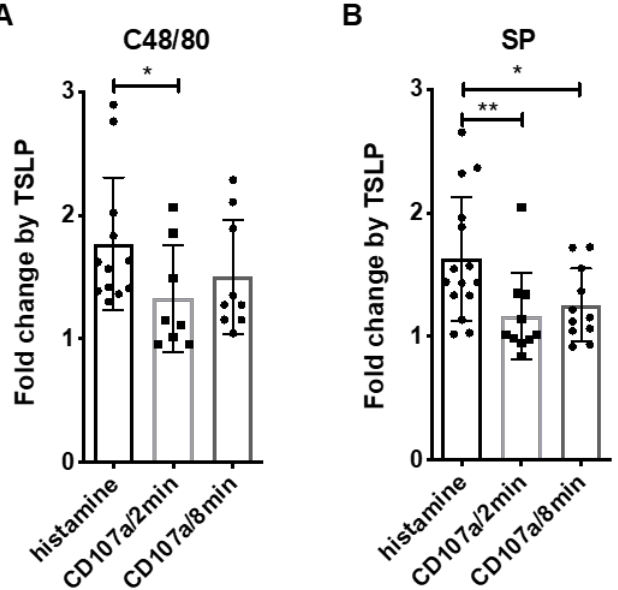
Figure 3. TSLP priming has greater impact on MRGPRX2-elicited histamine release than on CD107a exteriorization. The priming efficiency of TSLP (7.5 ng/mL) was compared between histamine release (according to Figure 1) and CD107a exteriorization (according to Figure 2). ( A ) c48/80 (10 µg/mL), ( B ) SP (30 µM). The data are presented as fold change (FC) by TSLP against control. Mean ± SD of n = 8–15 independent experiments. * p < 0.05, ** p < 0.01.